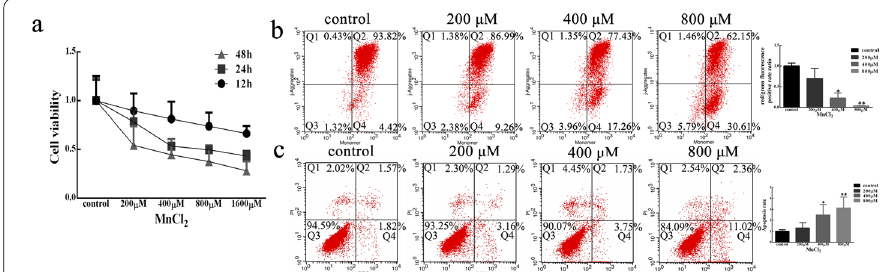
Fig. 1 MnCl 2 inhibited cell proliferation and induced apoptosis in SH-SY5Y cells. a SH-SY5Y cells were treated with 0–1600 μM MnCl 2 for 12, 24, 48 h. Then, cellviability was measured by CCK-8 assays. b , c Mitochondrial membrane potential ( b ) and cellapoptosis ( c ) were observed using the flow cytometry method (FCM) after SH-SY5Ycells were treated with 200, 400, and 800 μM MnCl